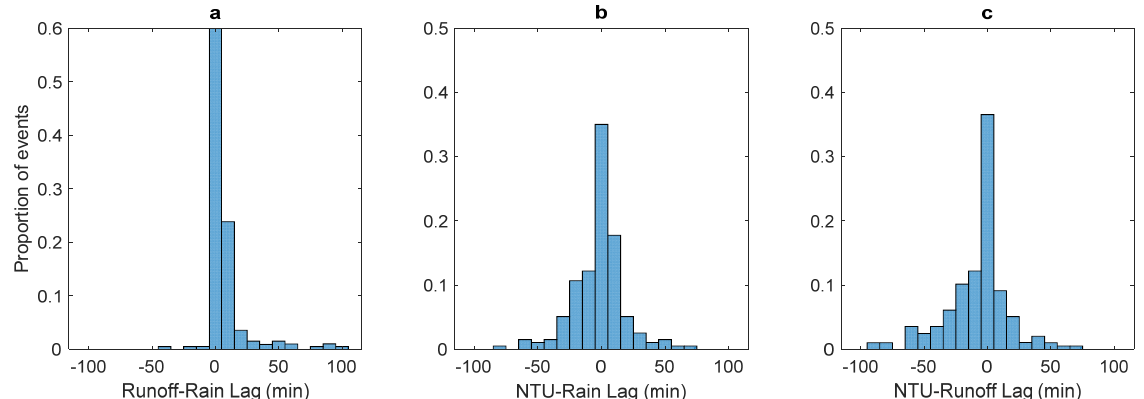
Figure 9. Lag time histograms: ( a ) time to peak runoff minus time to peak rainfall; ( b ) time to peak NTU minus time to peak rainfall; ( c ) time to peak NTU minus time to peak runoff.